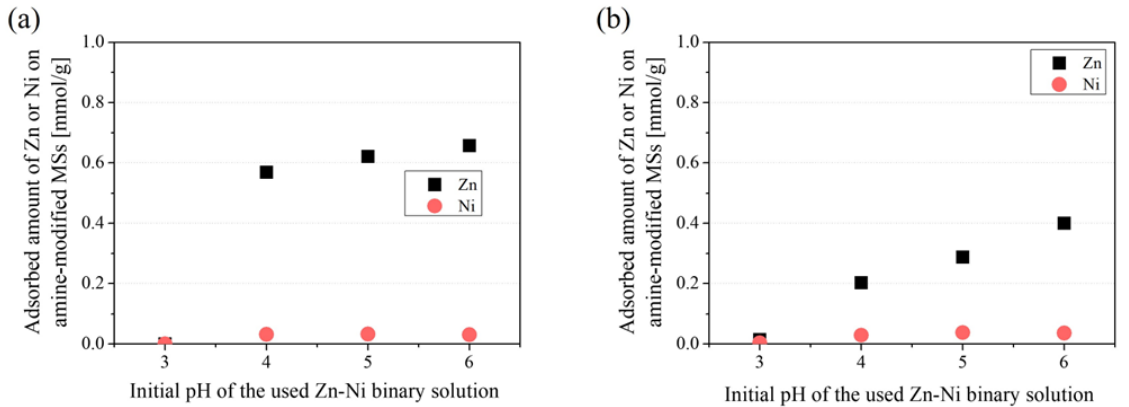
Figure 13. Effect of initial pH on adsorption amount of Zn and Ni on amine-modified MS prepared from MSs with initial pore sizes of 2.8 nm ( a ) and 9 nm ( b ) in the Zn–Ni binary system.